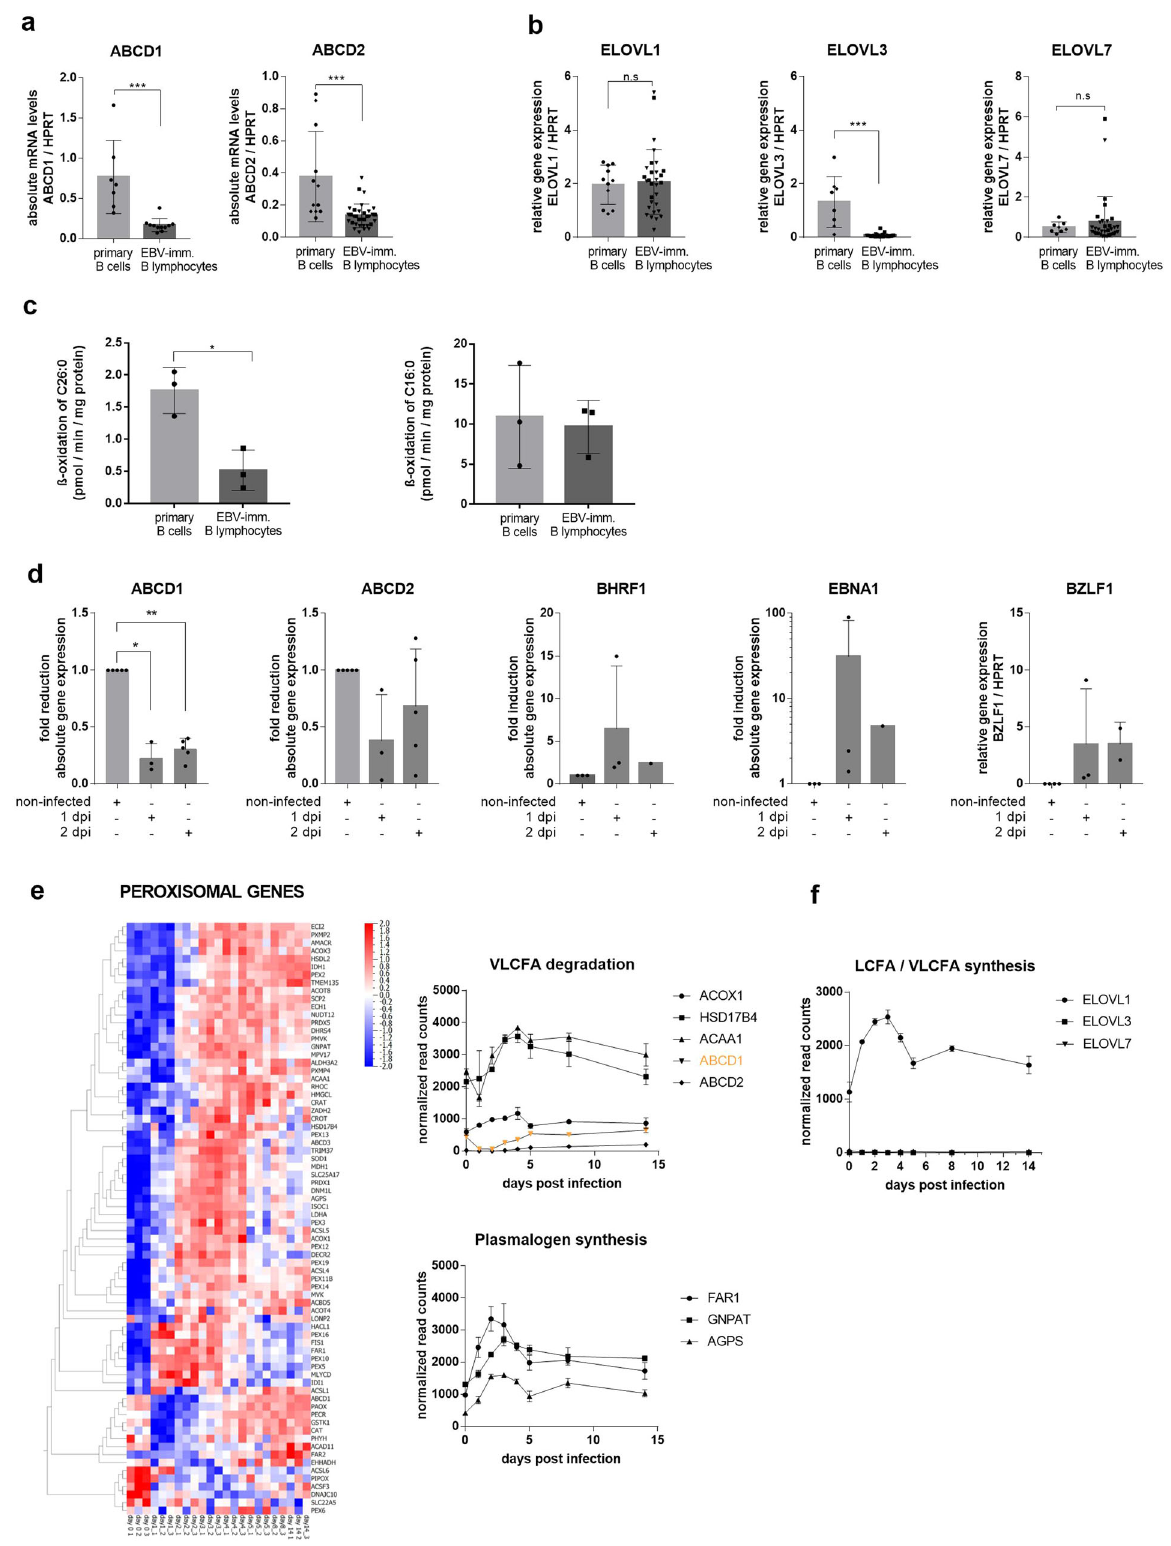
targeting miRNA negative controls. Moreover, a non-related 3 ′ -UTR sequence of the β -actin gene was not affected by these mimics. To verify a direct interaction of these miRNAs and the predicted target sequences, we performed in vitro mutagenesis of the binding sites and observed that mutations in the second target site (M-TS2) of the ABCD1 -3 ′ -UTR were suf fi cient to ablate the effect of the